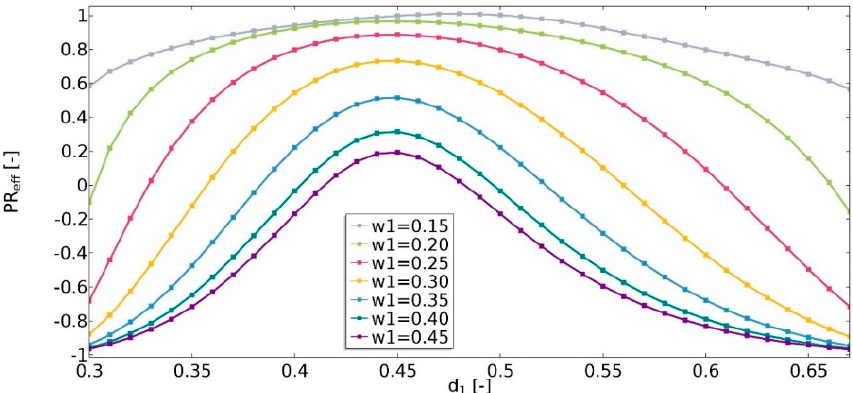
Figure 14. The influence of geometric features on the value of effective Poisson’s ratio.